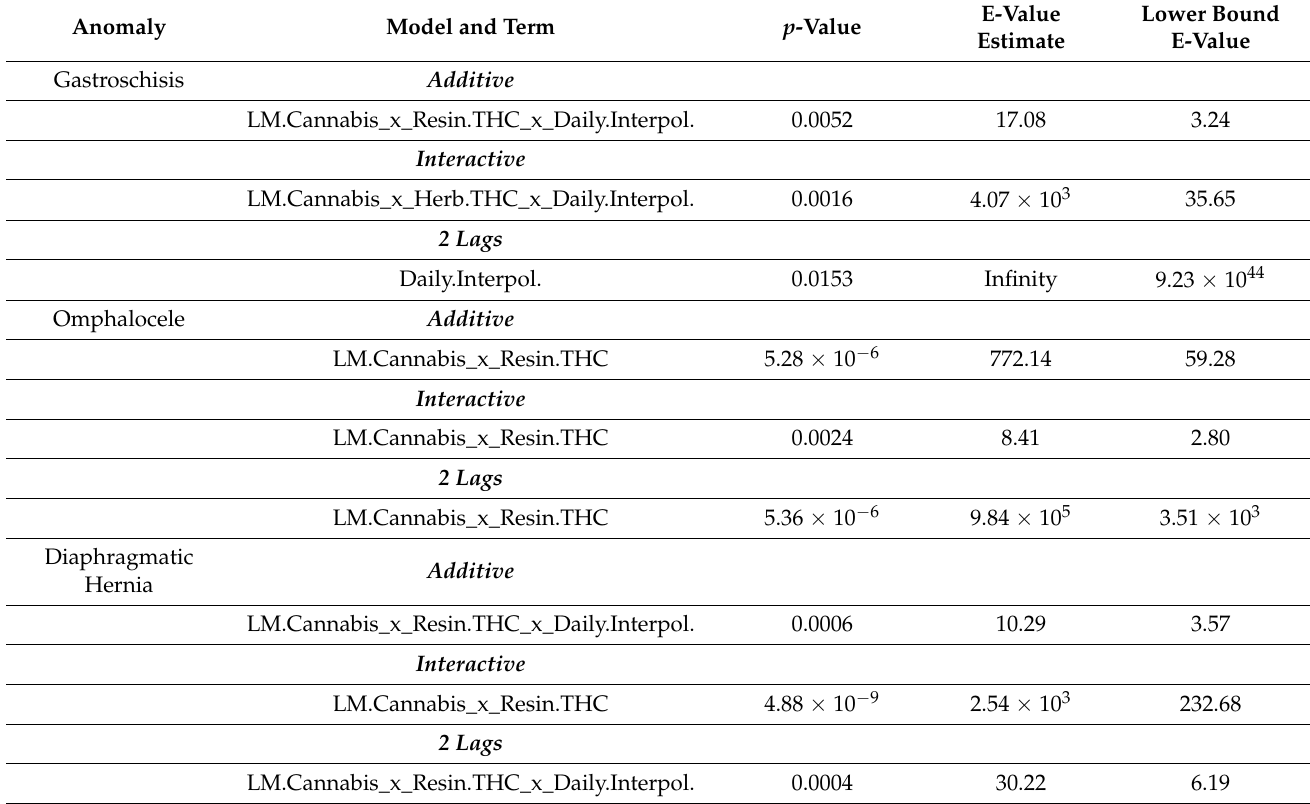
Table 6. E-Values from Geospatial